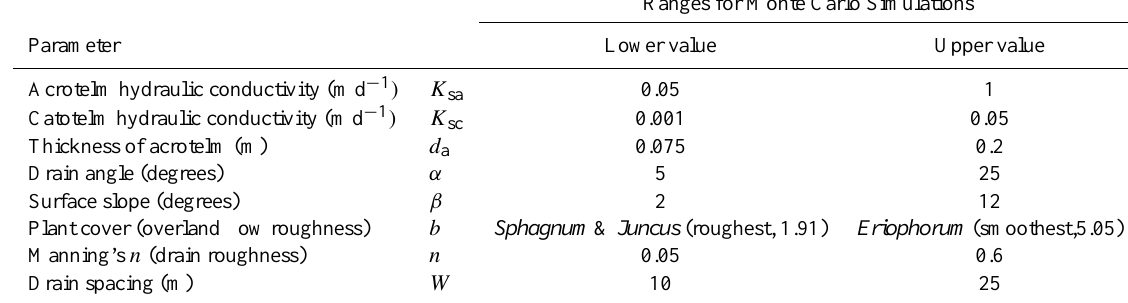
Table 2. Parameter ranges for scenario Monte Carlo simulations.